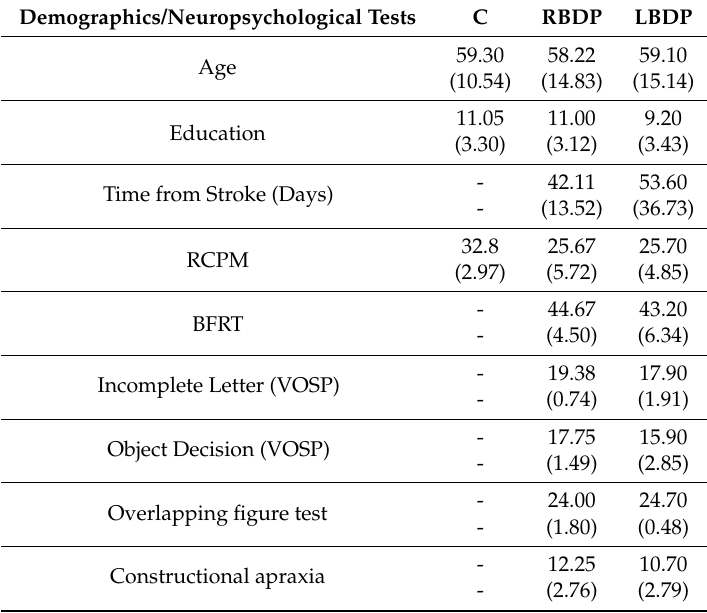
Table 4. Demographics and neuropsychological data. Notes. RCPM = Raven’s Colored Progressive Matrices; BFRT = Benton Facial Recognition Test; VOSP = Visual Object and Space Perception